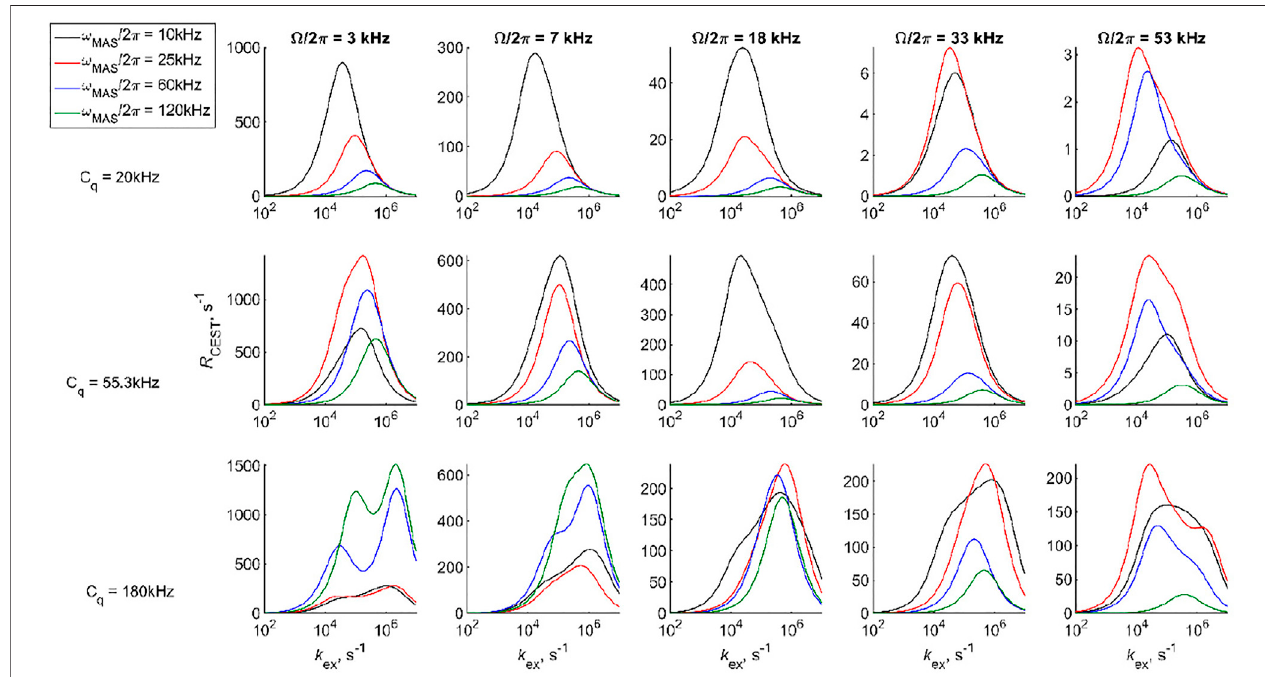
FIGURE 5 | Simulated values of R CEST versus k ex shown for several selected offsets for the 2-site jump model with equivalent axially symmetric tensors, an equal population of sites, and a jump angle of 106 ° . The R CEST values were obtained for integrated spectral band intensities with a single exponential approximation to the decaycurvesfor T inthe0.25 – 128 msrange. ω RF / 2 π was fi xedat1.3 kHzandthefourMASratesof10,25,60,and120 kHzwereselected.Thethreevaluesof C q of20, 55.3, and 180 kHz were